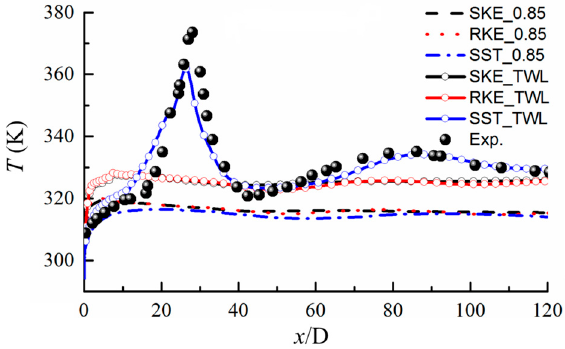
Figure 6. Variation of wall temperature ( q = 56.7 kW/m 2 ).